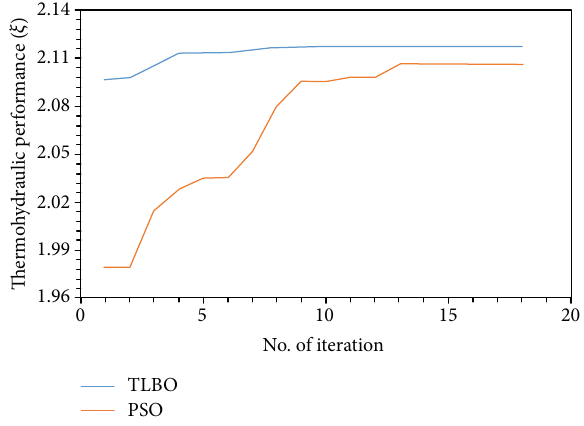
Figure 9: Convergence plot of thermohydraulic performance for PSO and TLBO techniques